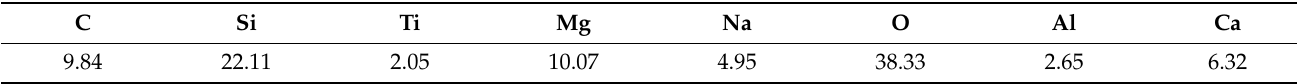
Table 4. Typical composition of Ti-bearing phase in solidified slag,